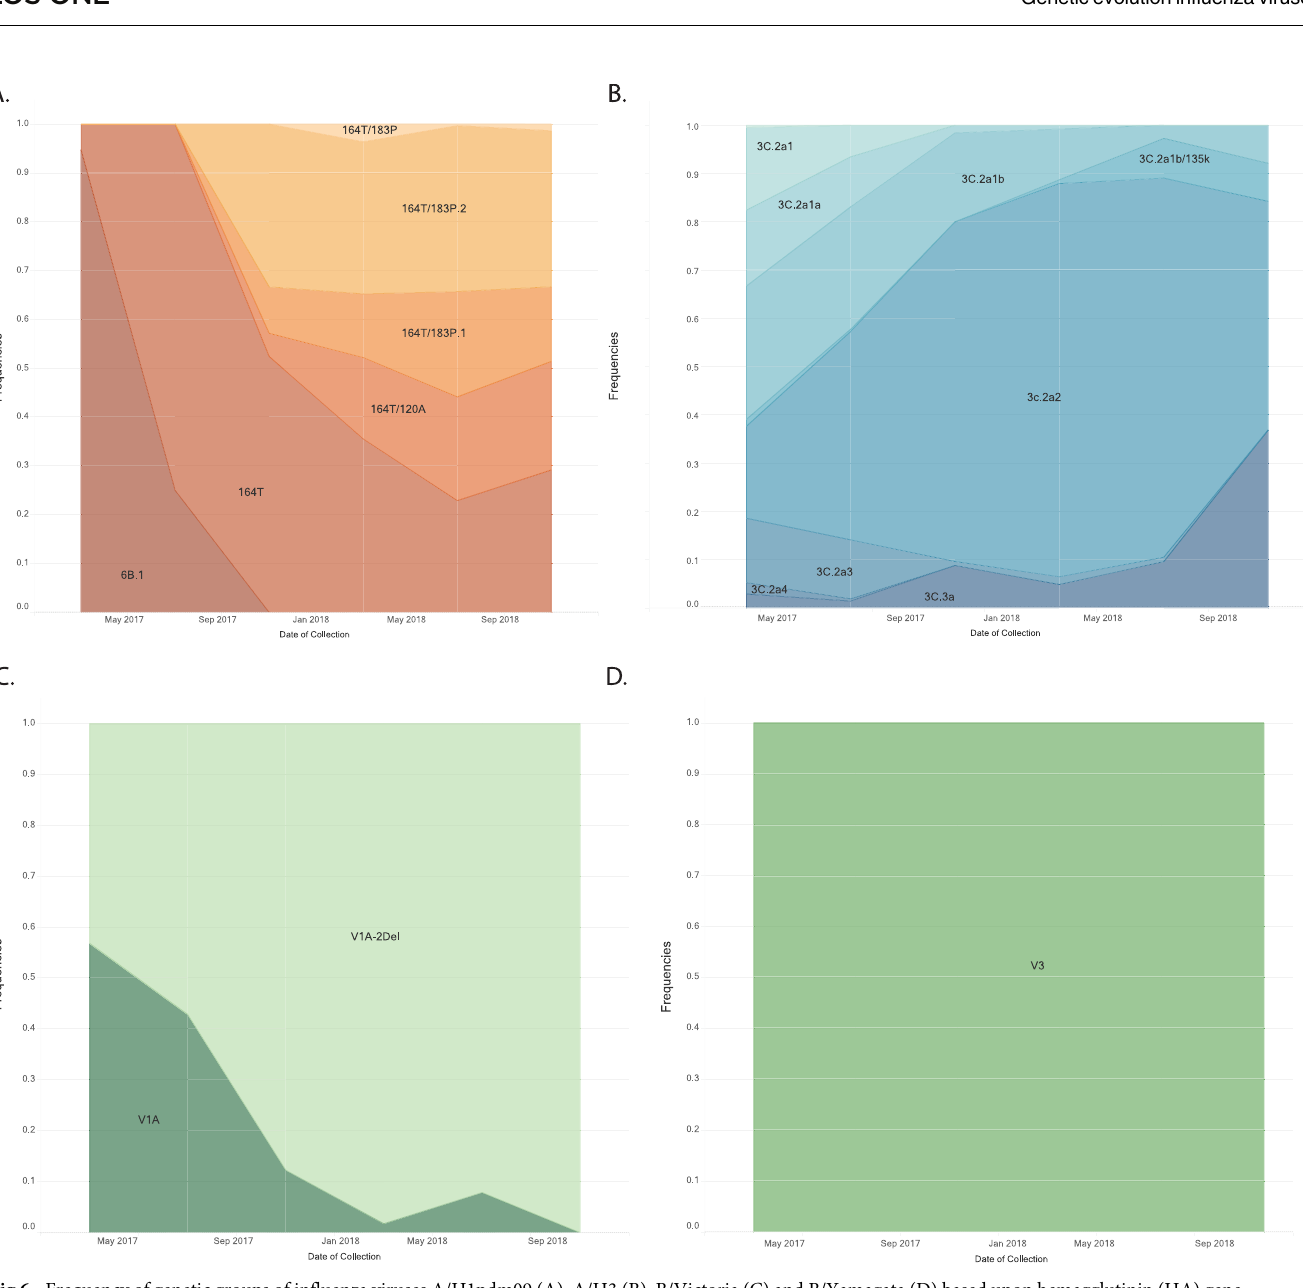
Fig 6. Frequency of genetic groups of influenza viruses A/H1pdm09 (A), A/H3 (B), B/Victoria (C) and B/Yamagata (D) based upon hemagglutinin (HA) gene sequences from participating countries and other Latin American and Caribbean countries, May 1, 2017 through October 26, 2018.